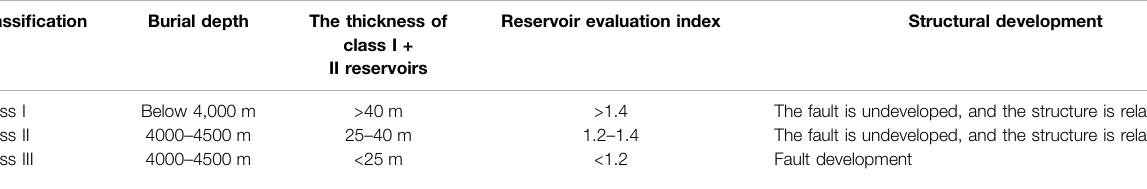
TABLE 4 | Classi fi cation standards of favorable areas in the study area.